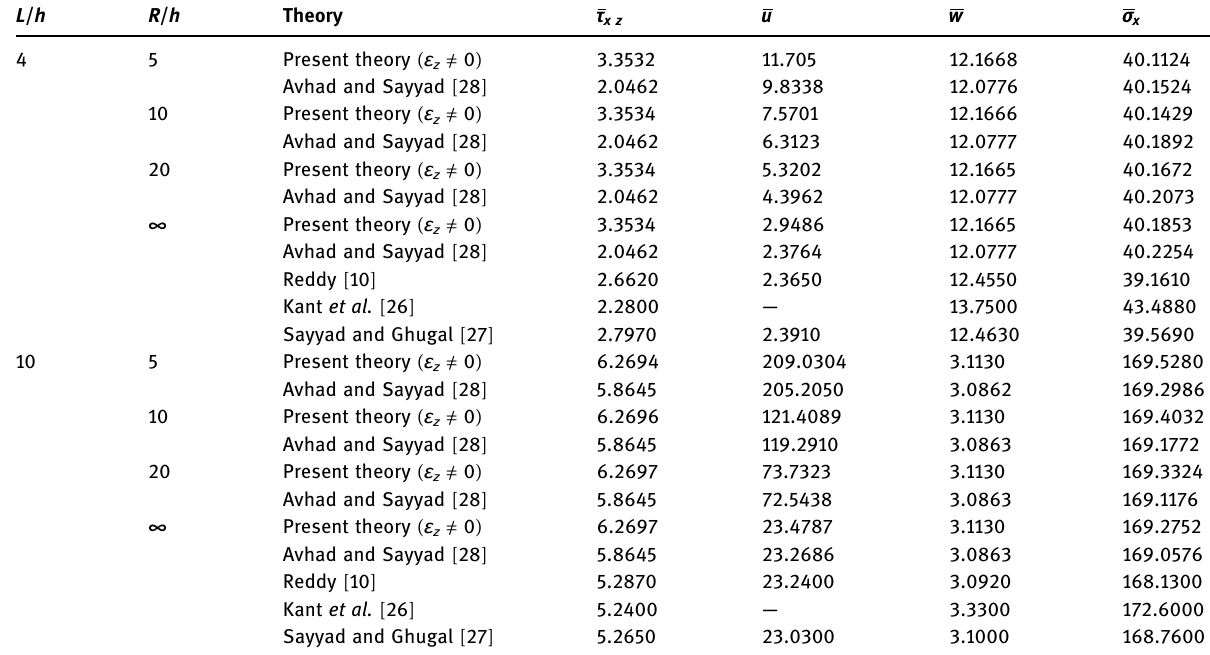
Table 5: Assessment of non - dimensional transverse shear stresses, axial displacements, transverse displacements, and axial bending stresses for sandwich ( 0°/Core/0° ) arches